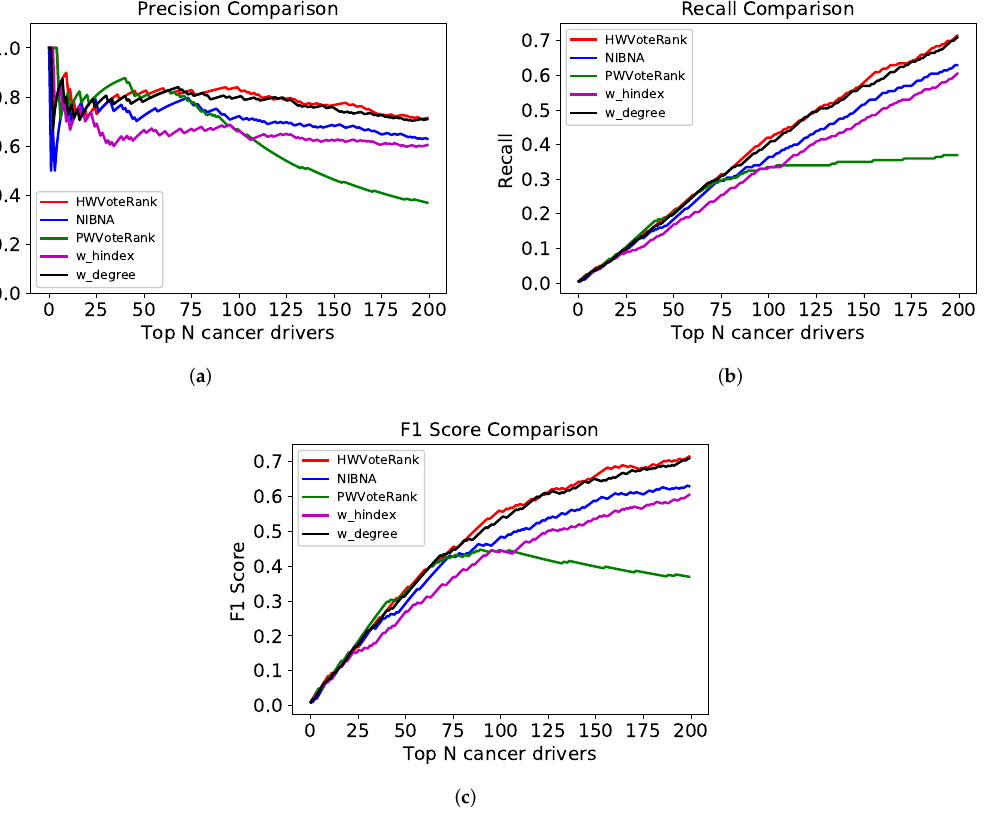
Figure 2. Performance comparison among PHVoteRank, NIBNA, HWVoteRank, w_hindex, and w_degree in top 200 predicted cancer drivers, excluding genes without mutations. ( a ) is the precision comparison, ( b ) is the recall comparison, and ( c ) is the F1 score